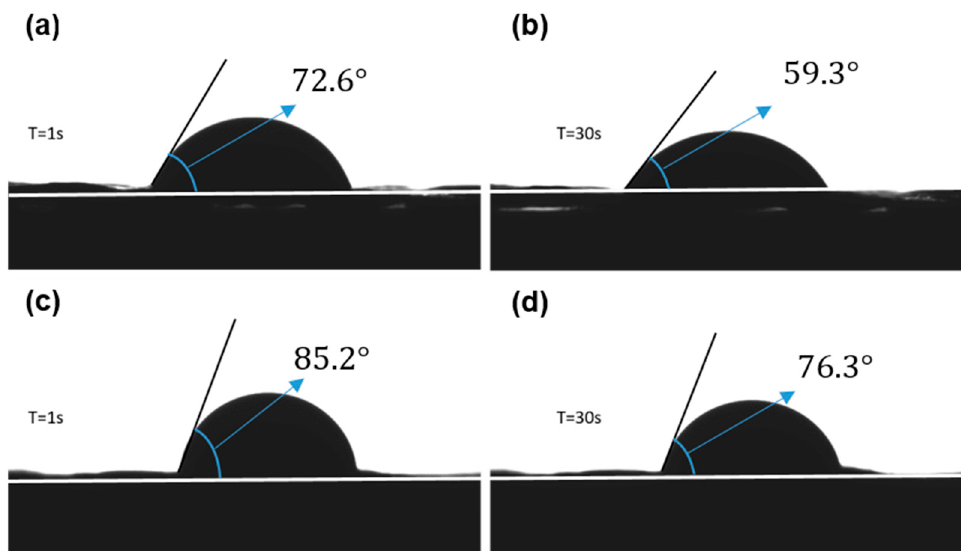
Figure 7. Contact angle for both sides of the leaf. ( a ) T = 1 s and ( b ) T = 30 s for adaxial, and ( c ) T = 1 s and ( d ) T = 30 s for abaxial. Table 5. Contact angle and surface energy measurements for both sides of the